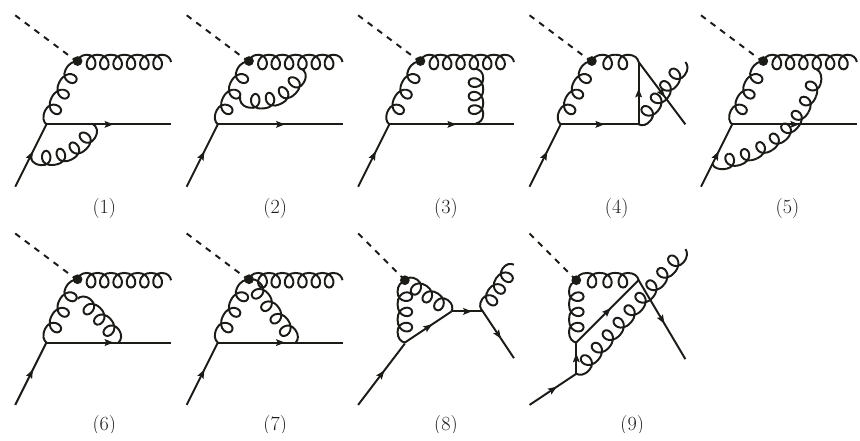
Figure 2 . One-loop corrections to the scattering of a quark o(cid:11) a virtual Higgs boson. Only the triangle and box diagrams are